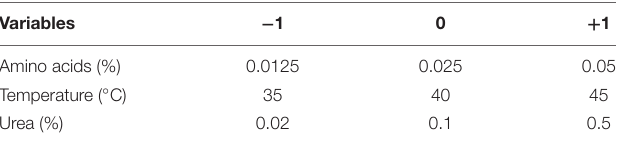
TABLE 3 | Levels of the selected variables used in Box–Behnken for optimization of GSH production. Variables